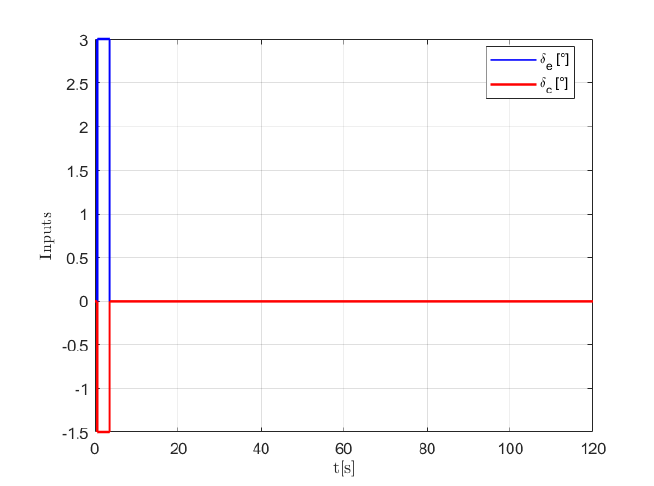
Figure 11. Pilot control set-points δ e